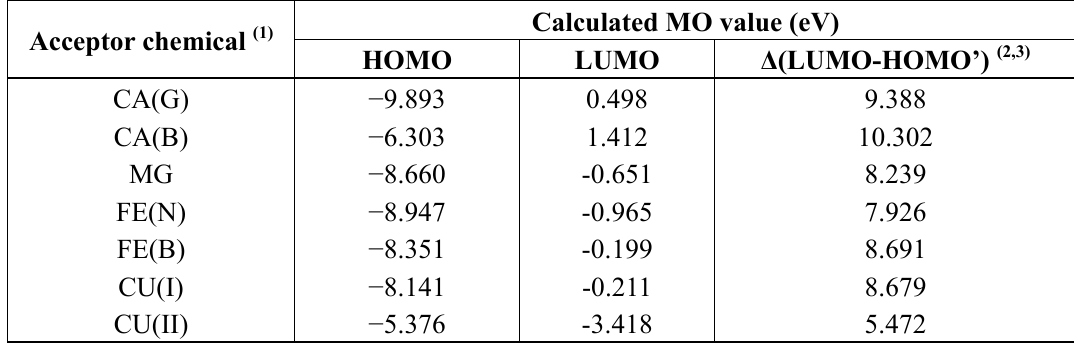
Table 4. Results of molecular orbital (MO)